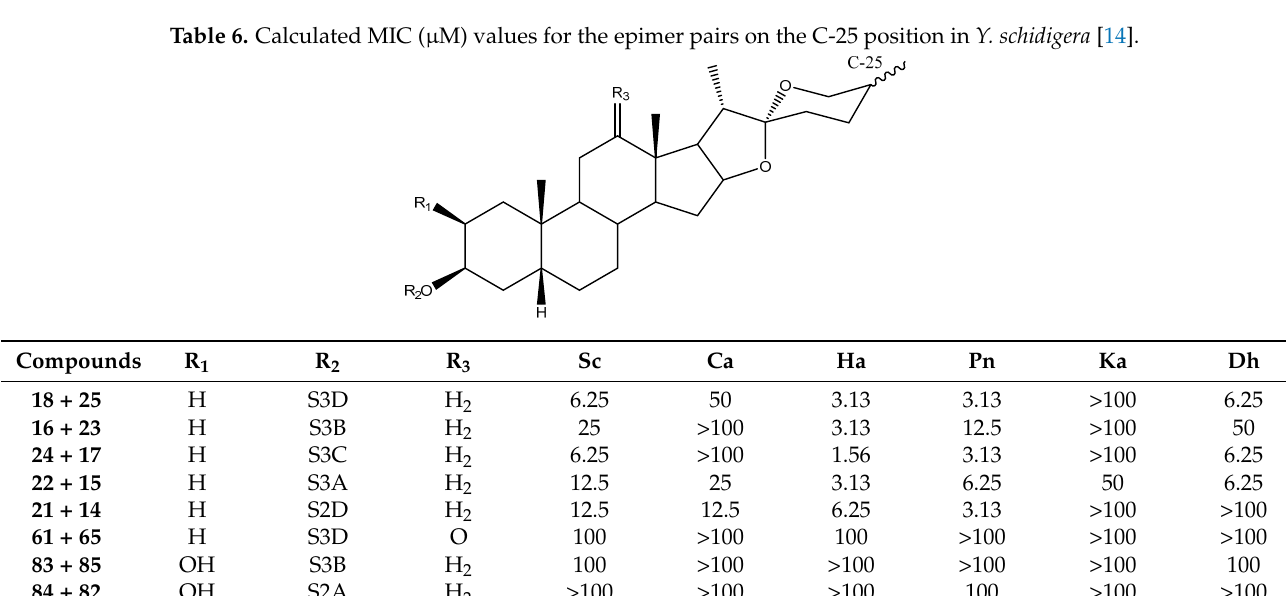
Table 6. Calculated MIC ( μ M) values for the epimer pairs on the C-25 position in Y. schidigera [14].